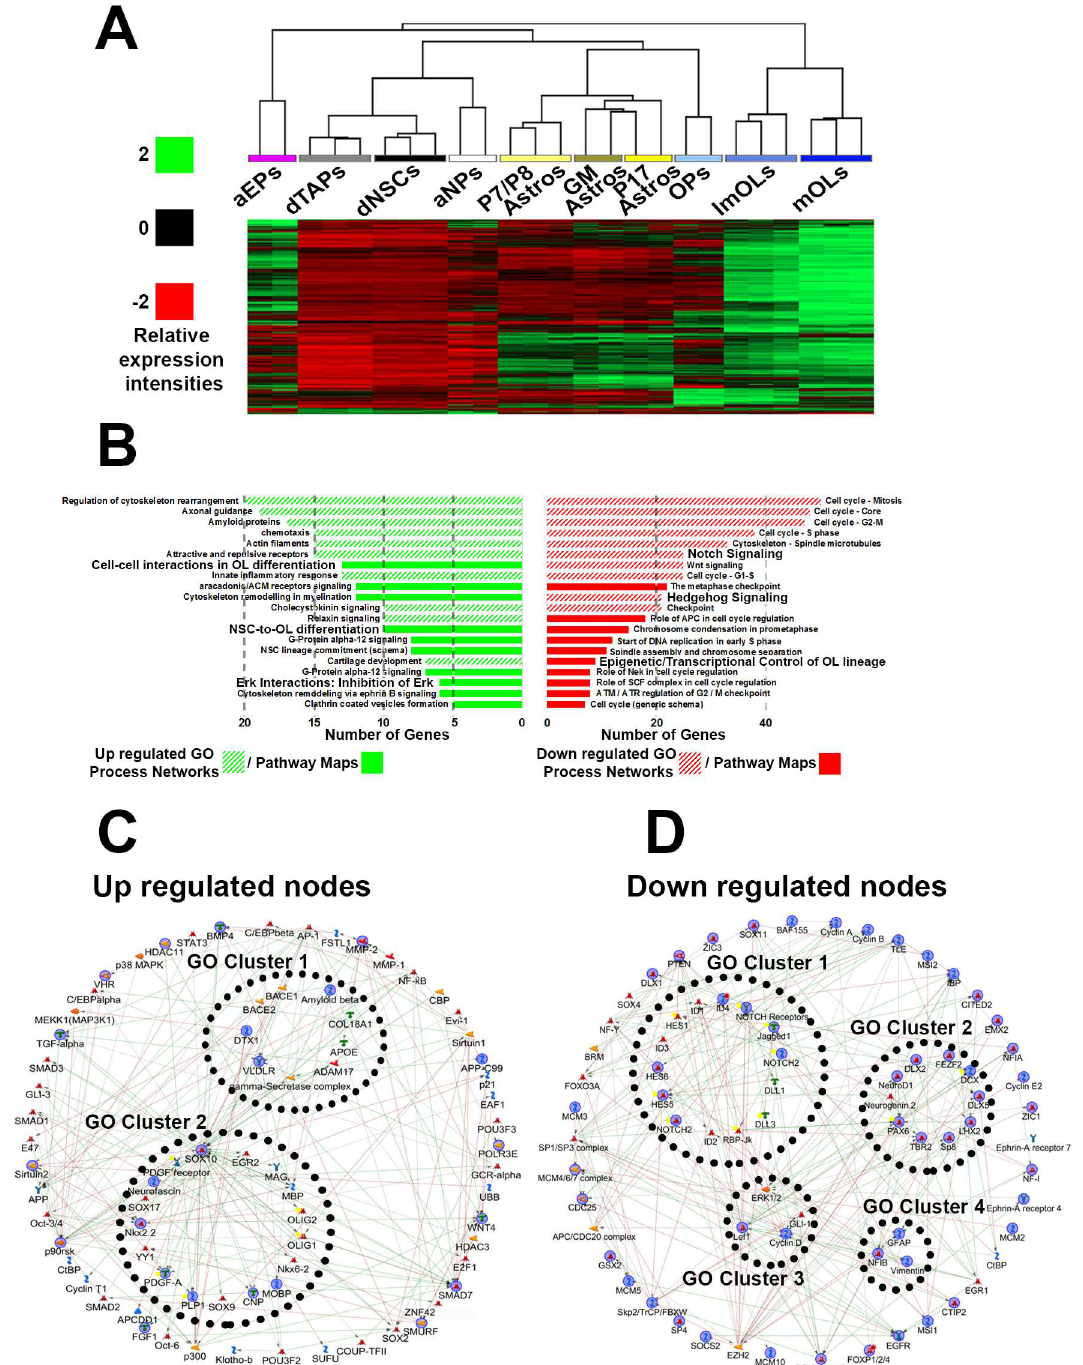
Fig 3. Connectivity map (CMAP) pathway and network analysis for LY-294002target genes. Gene list generated to obtain the drug profilesfor LY-294002(S5 Table)was utilizedto compilethe CMAP “LY-294002 target-gene” list, and genes prospectively up-regulated are presented as a heatmapin (A) showingenrichment in later oligodendrocyte (OL) lineage cells and down-regulation in dorsalneural stem cells (NSCs) or transient amplifyingprogenitors (TAPs). aEPs, adult ependymas; aNPs, adult neuronalprecursors(NPs); GM, grey matter; astros, astrocytes; imOLs, immature OLs; mOLs, mature/myelinatingOLs. (B) Prospectively up-regulated or down-regulated genesanalyzedby GenegoMetacore for GO Pathway Maps and Process Networks, and lists are ranked accordingto significance(false discovery rate [FDR] < 2%)/ numbers of genespresent in each of the categories. (C, D) Short path network to visualizehighly connectedsignaling-to-